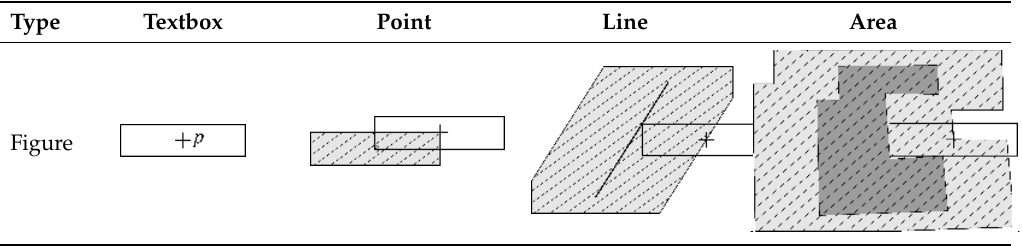
Table 1. Regions of “immovability” for the basic point, line, and area features.